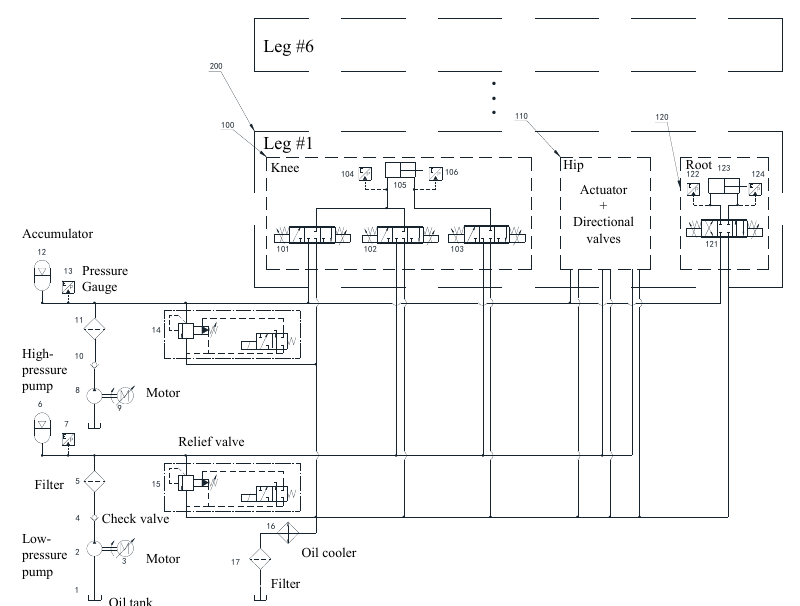
Figure 2. Schematic of the two-stage supply pressure hydraulic system (TSS).